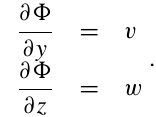
Figure 2. Sketch of the stream tube used to describe the disc actua- tor approach. The dashed lines represent the inflow, rotor and outlet cross sections, which are indicated with the subscripts i, r and o in the definition of the diameter D and the section-average wind speed U SA